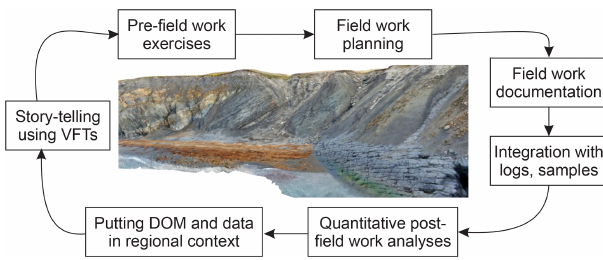
Figure 9. Applications of DOMs for concrete usage in